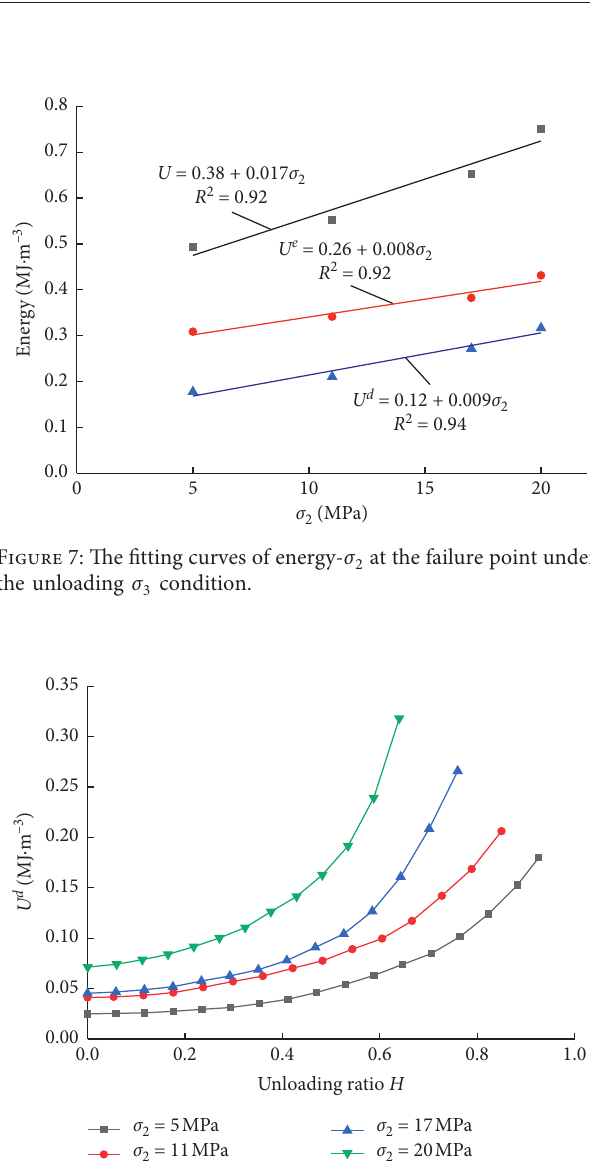
Figure 8: Dissipated energy-unloading ratio curves.